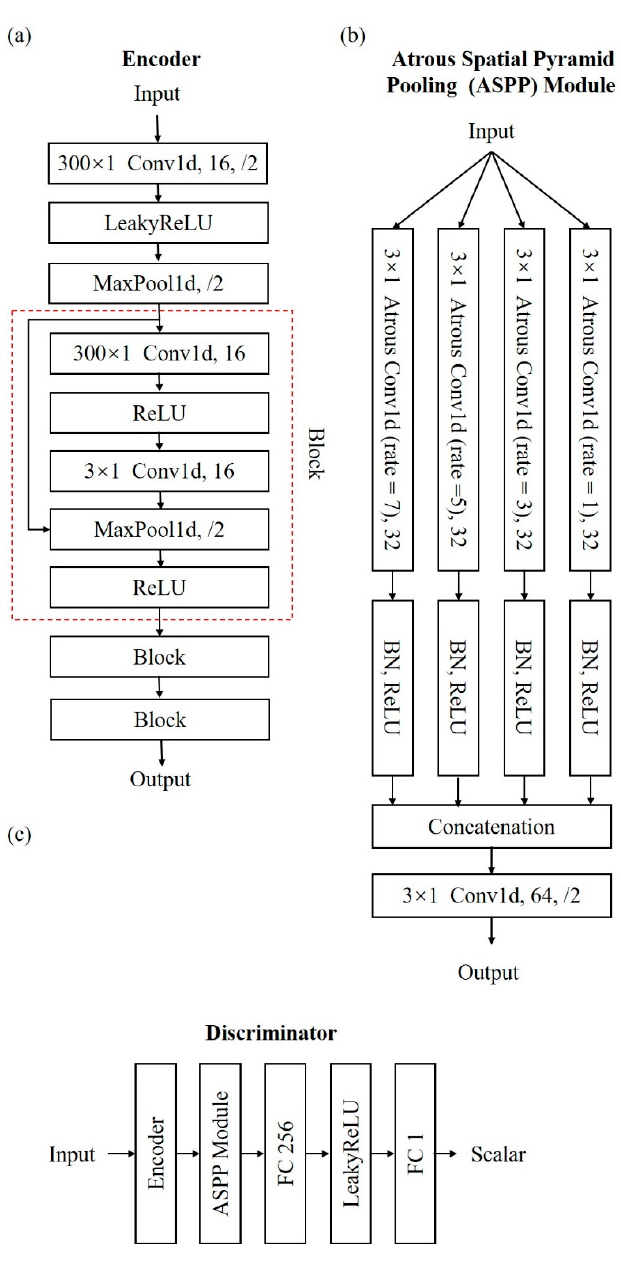
Figure 2. The architecture of ( a ) encoder, ( b ) Atrous spatial pyramid pooling (ASPP) module and ( c ) discriminator.